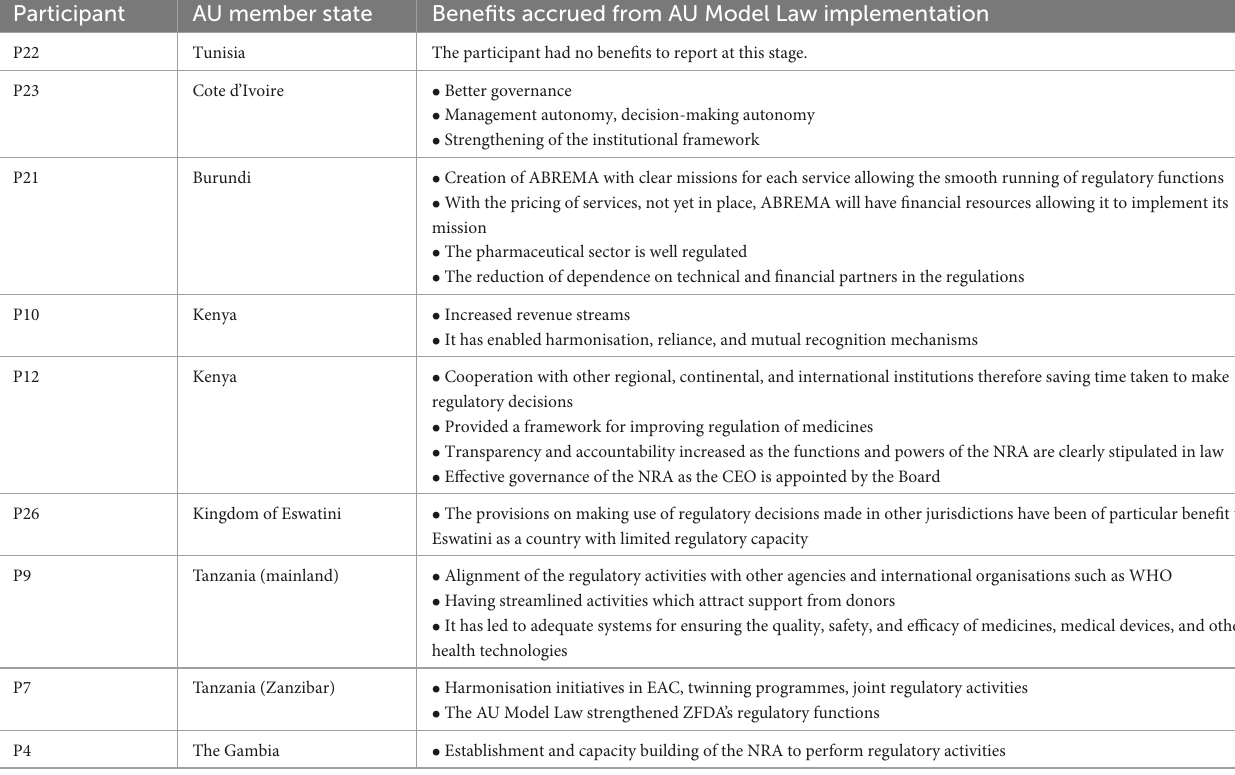
TABLE 3 The benefits of AU Model Law implementation reported by seven African national medicines regulatory authorities (NRAs) ( N = 9). Participant AU member state Benefits accrued from AU Model Law implementation P22 Tunisia The participant had no benefits to report at this